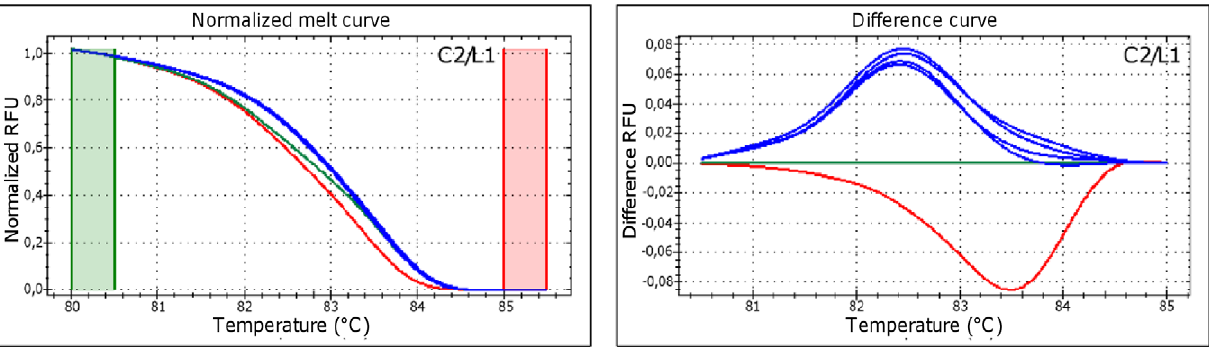
Figure 4. Inplanta performances of multiplex HRM analysis for discrimination of P.savastanoi pathovars. Normalized and difference plots obtained in multiplex HRM assay, performed using the couple of primer pairs for SNP markers C2/L1 on Oleander plants inoculated with Psn23 . Pure genomic DNAs from Psv5 , Psn23 , and Psf134 were also tested as controls. On each plot different colors indicate distinct profiles, generated by Psv5 , Psn23 and Psf134 (red, blue and green trace, respectively). Three Psn23 artificially infected plants were tested for each of the three independent Real-Time PCR runs performed. RFU: Relative fluorescence units. Green and red columns represent pre- and post-melting normalization regions.